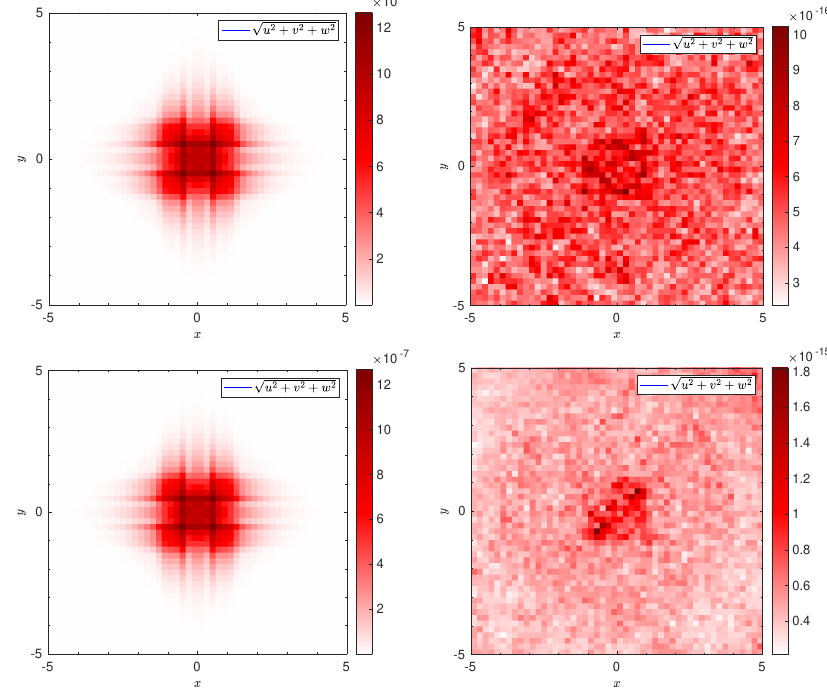
√ u 2 + v 2 + w 2 for the stationary problem (68) (dispersive Figure 14. Computed velocity norm Gavrilyuk–Favrie equations) at time t = 10 s with the fourth order non well-balanced ( left ) and well-balanced ( right ) methods. An uniform Cartesian mesh of N x × N y = 50 × 50 elements has been used. Upper and lower panels stands for Runge–Kutta and ADER time-marching discretisations,